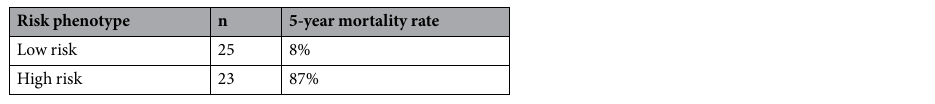
Table 2. Mortality rate for the dichotomised risk phenotype developed using human engineered image features extracted from CT chest scans. There was no censoring.